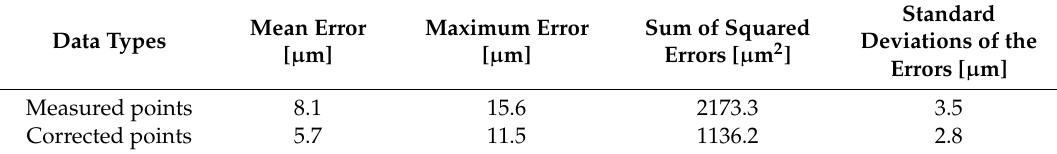
Figure 19. Comparison of the certified, measured, and corrected positions. Table 7. Errors with respect to the certified positions before correction and after correction.